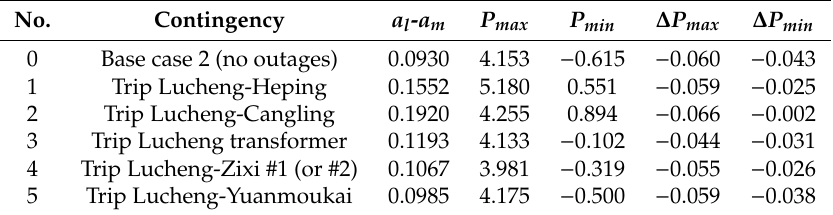
Table 2. Estimation method results under operating condition